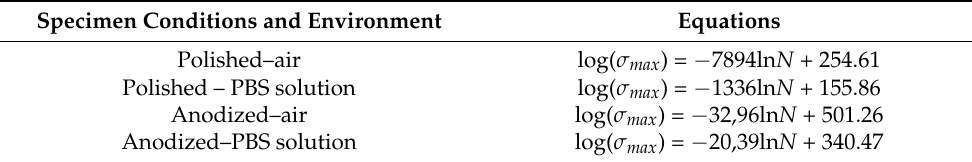
Table 3. Fitting equations for each experimental condition.